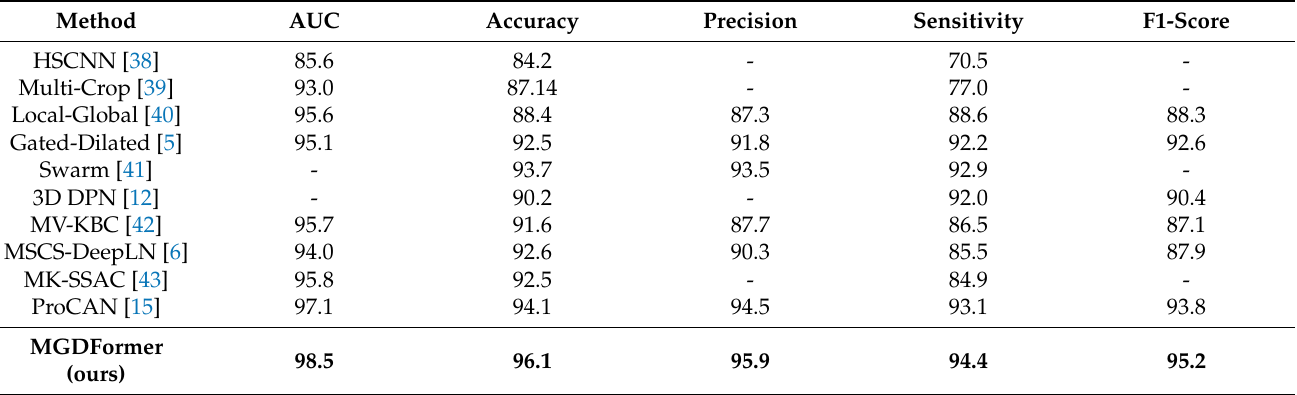
Table 1. Comparisons of state-of-the-art methods on the LIDC-IDRI